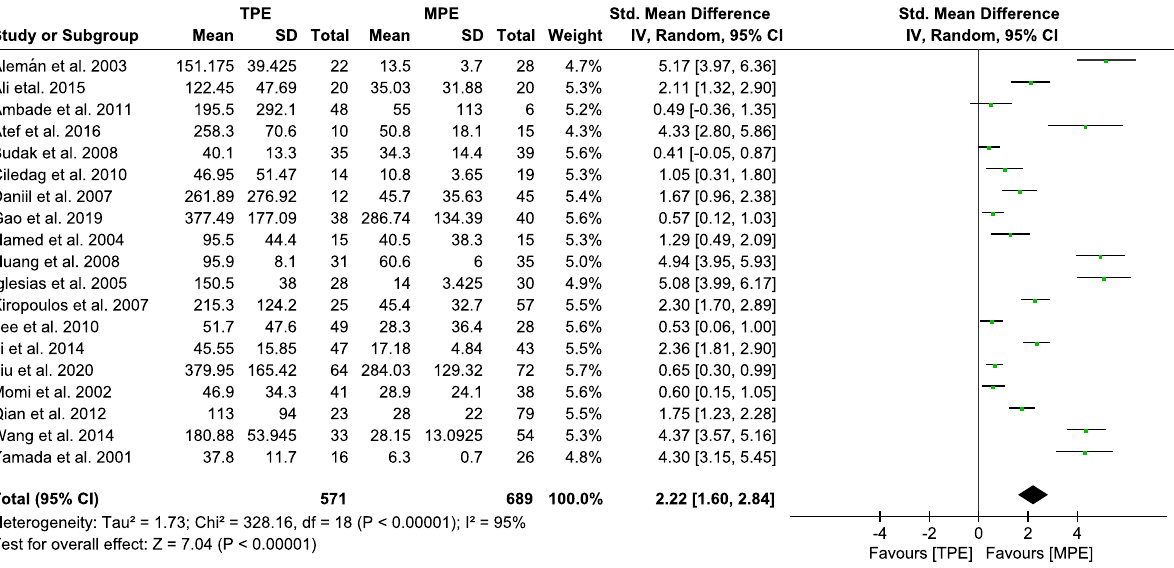
Figure 2. Forest plot of 19 studies comparing TNF-α levels in TPE and MPE subjects. The standardized mean difference (the pleural effusion levels of TNF-α in TPE subjects minus that in MPE subjects) was estimated by meta-analysis.